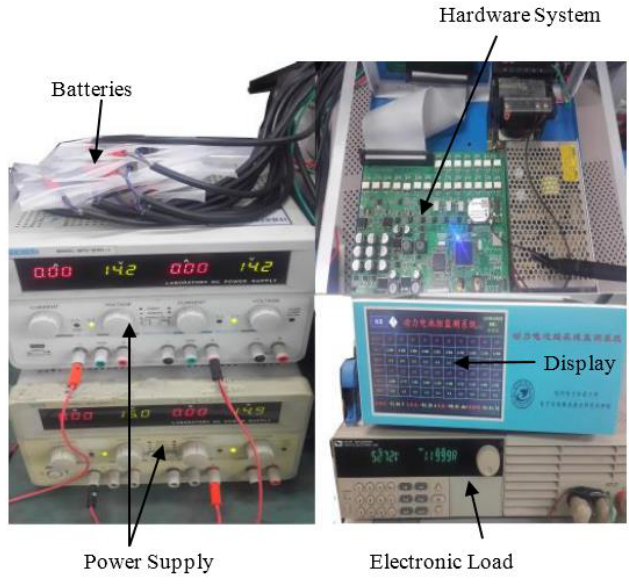
Figure 1. Our designed measurement system.